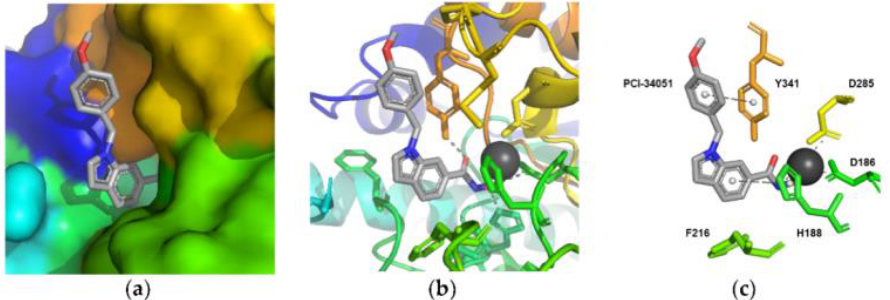
Figure 5. Representation of the crystal structure of mutant sm HDAC8-H292M in complex with compound 1 (PDB code: 6HSF): close-up view of the HDAC8-specific pocket shown as ( a ) surface representation ( b ) ribbon and stick ( c ) schematic binding interactions with the principal residues. The crystal structure was downloaded from the Protein Data Bank, visualized by Pymol, ( a ) and ( b ), and analysed for protein-ligand interactions profiles using PLIP online server ( c ) [138]. PCI-34051 ( 1 ) is depicted in light grey.